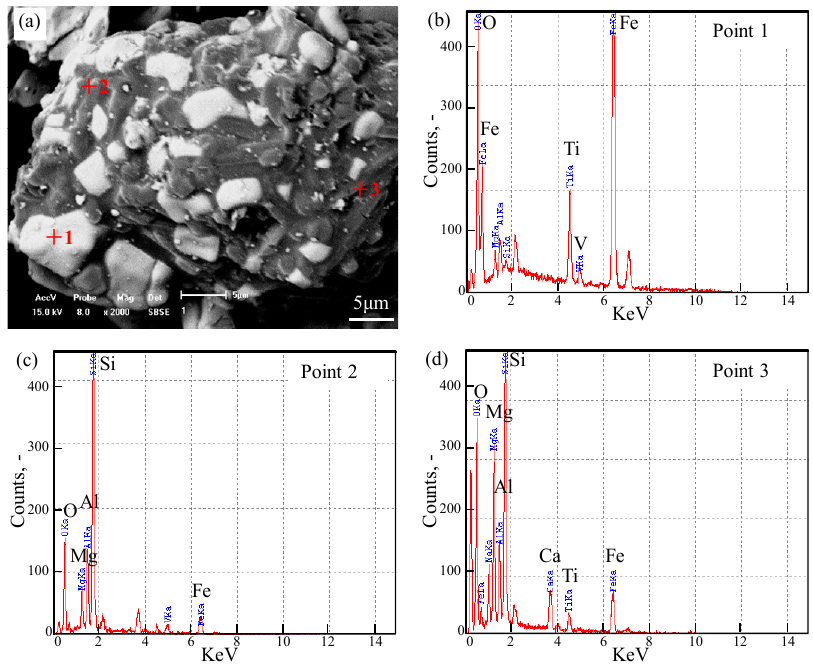
Figure 9. SEM micrograph and EDS of the roasted product at 1250 °C: ( a ) SEM micrograph; ( b ) EDS of Point 1 in Figure 9a; ( c ) EDS of Point 2 in Figure 9a; ( d ) EDS of Point 3 in Figure 9a.